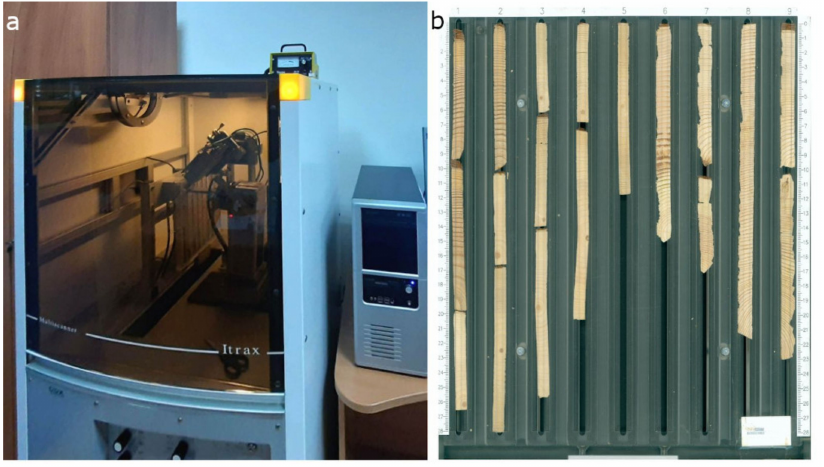
Figure 2. The Itrax Multiscanner facility ( a ) and the wooden slices in a plastic holder ( b ) ready for